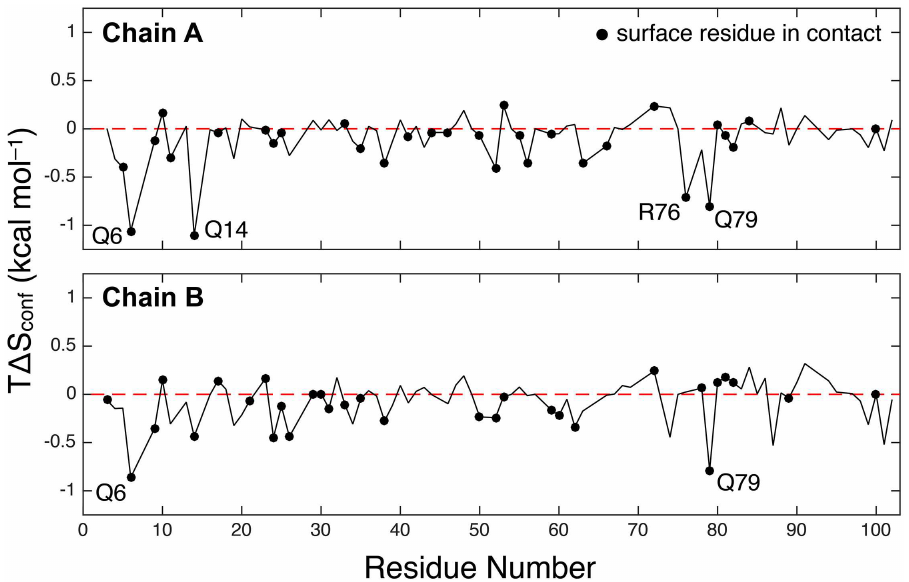
Fig 3. Differencesin side-chain conformational entropy in the crystalfor CVN. T Δ S conf is shownas a function of residue numberfor chains A (top) and B (bottom). Negative T Δ S conf values denotea loss in side- chain conformational entropy in the crystal; a dashedhorizontal line is shown in red at T Δ S conf = 0 (i.e., no changein side-chaindynamics). Residuesthat exhibit a large decreasein T Δ S conf are denotedby their one- letter amino acid abbreviation and number. Contacting surface residues are indicatedby filled